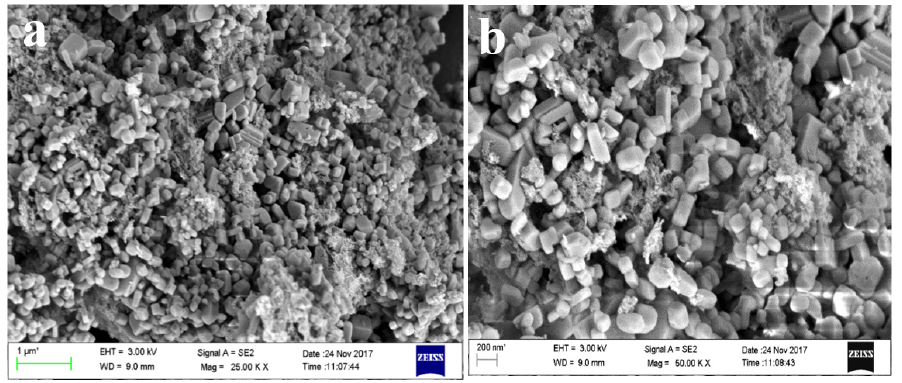
Figure 11. ( a ) FESEM micrograph of FISAR and ( b ) FESEM micrograph of gismondine zeolite adopted from Yadav et al. [84] .